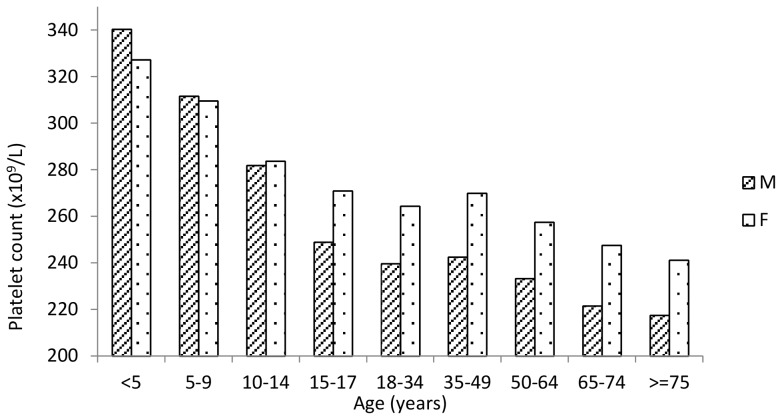
Platelet count by age in the examined populations.